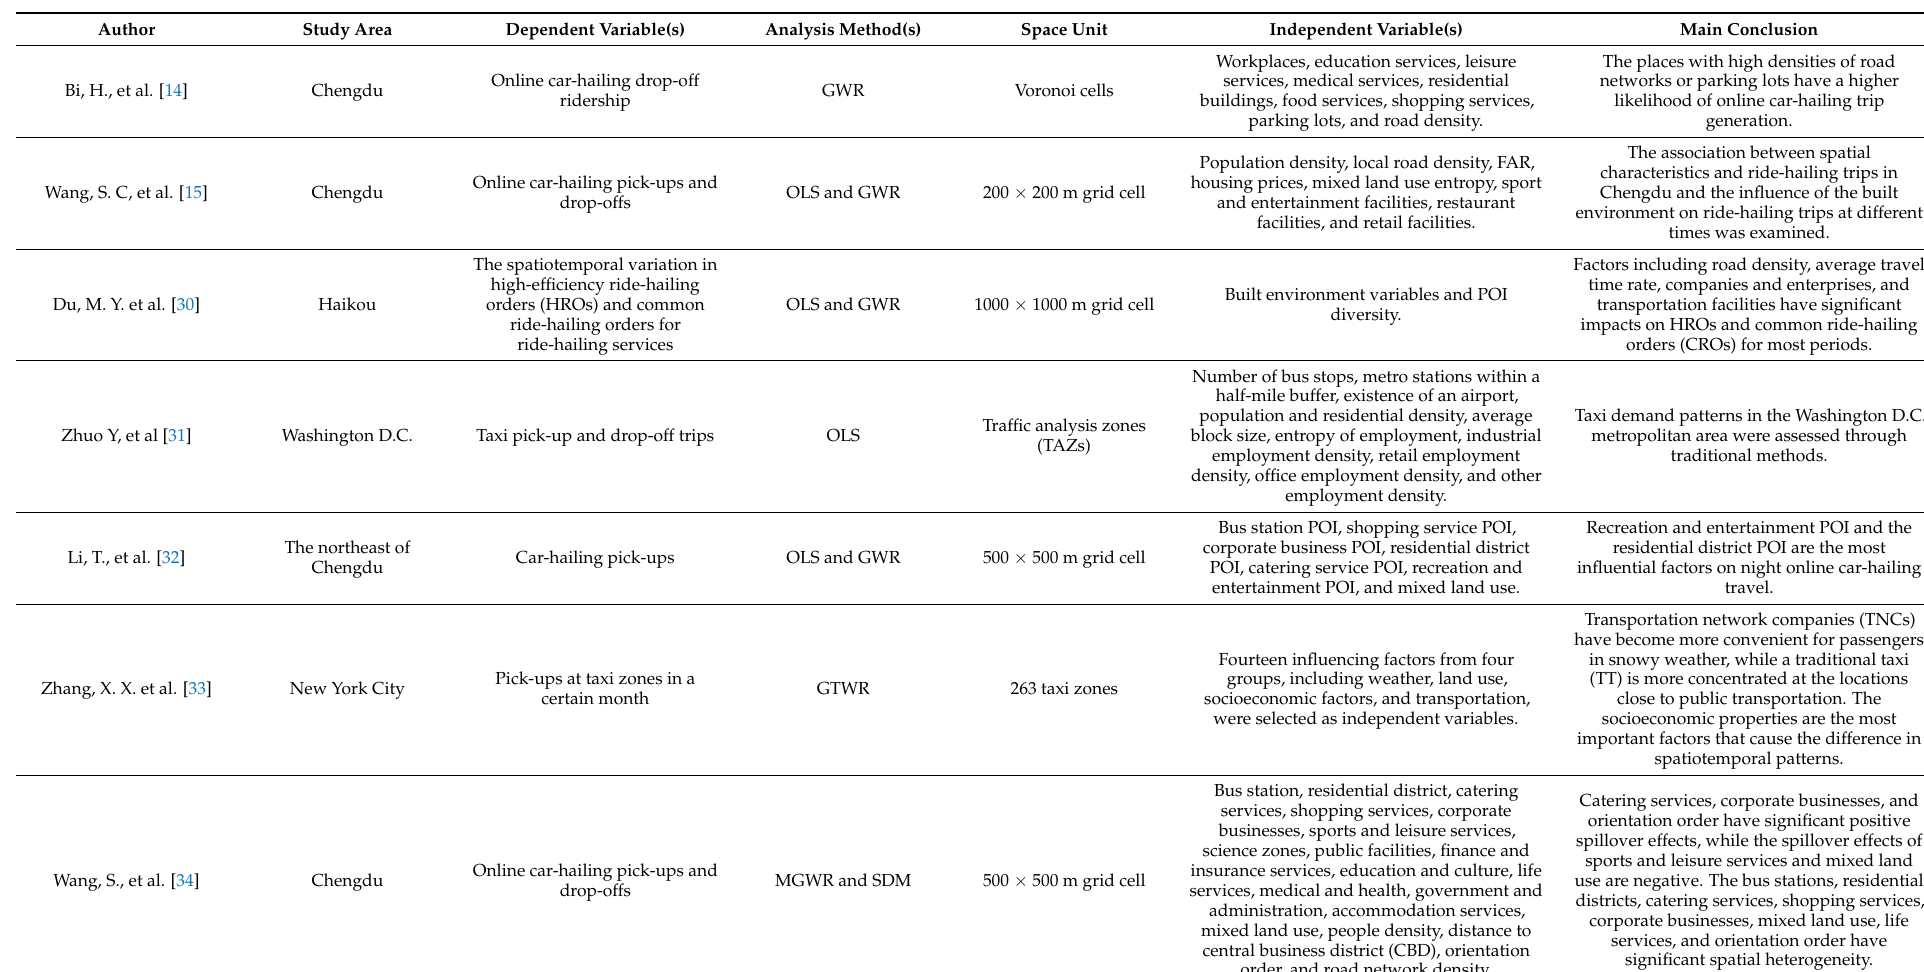
Table 1. Summary of relevant research on